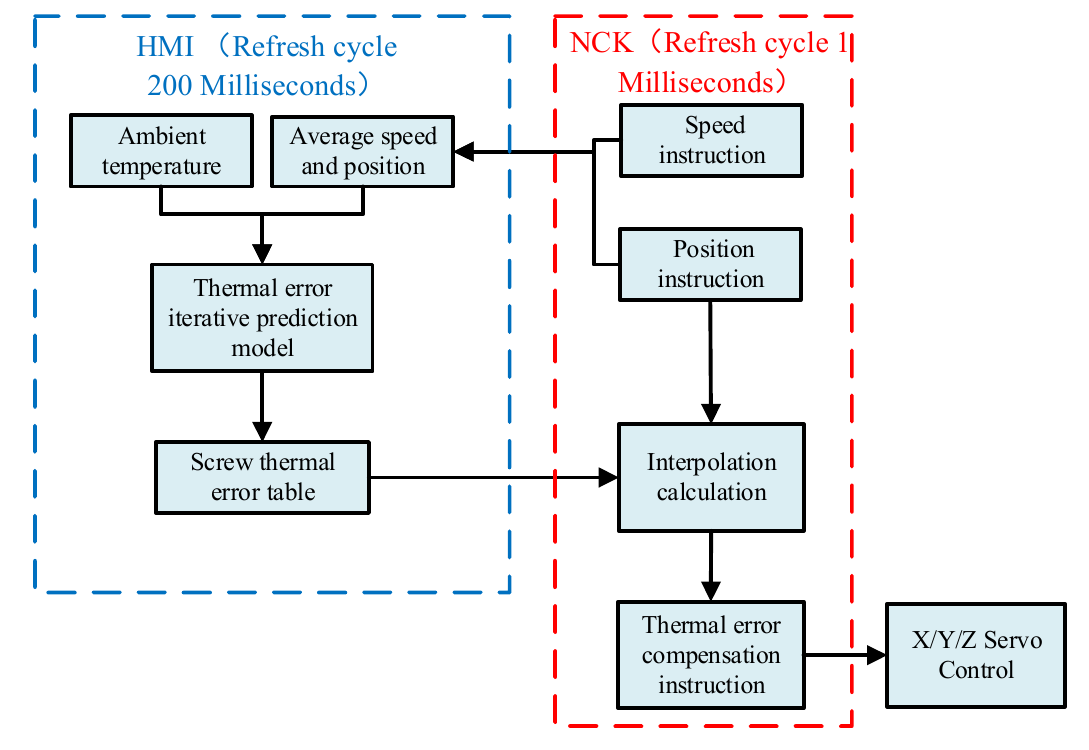
Figure 5. Implementation of the thermal error compensation module in the CNC system.